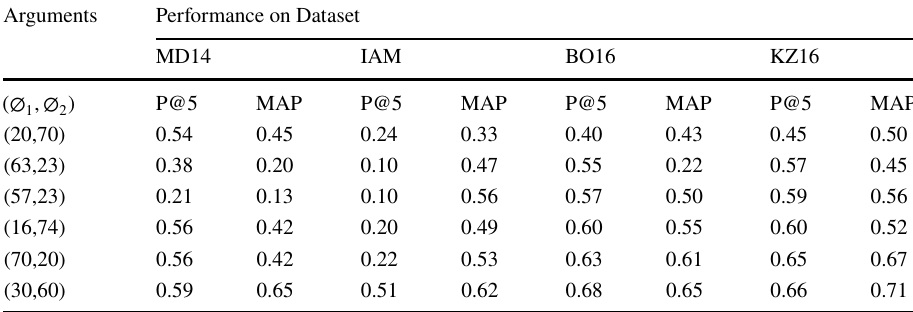
Here MD14, BT16, and KZ16 represent ICFHR 2014 Modern, ICFHR 2016 Botany, and ICFHR 2016 Konzilsprotokolle